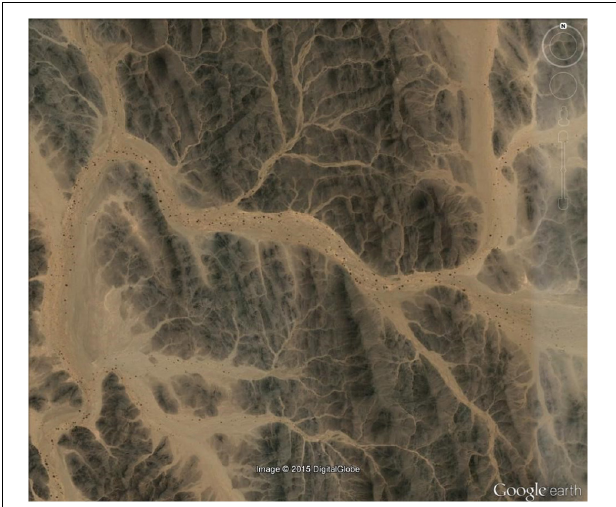
FIGURE 8 | Google Earth view showing an example of M . argun habitat and the network of seasonal watercourses (the geographic coordinates: 20 ◦ 59 (cid:48) 34.96 (cid:48)(cid:48) N, 34 ◦ 40 (cid:48) 00.20 (cid:48)(cid:48)